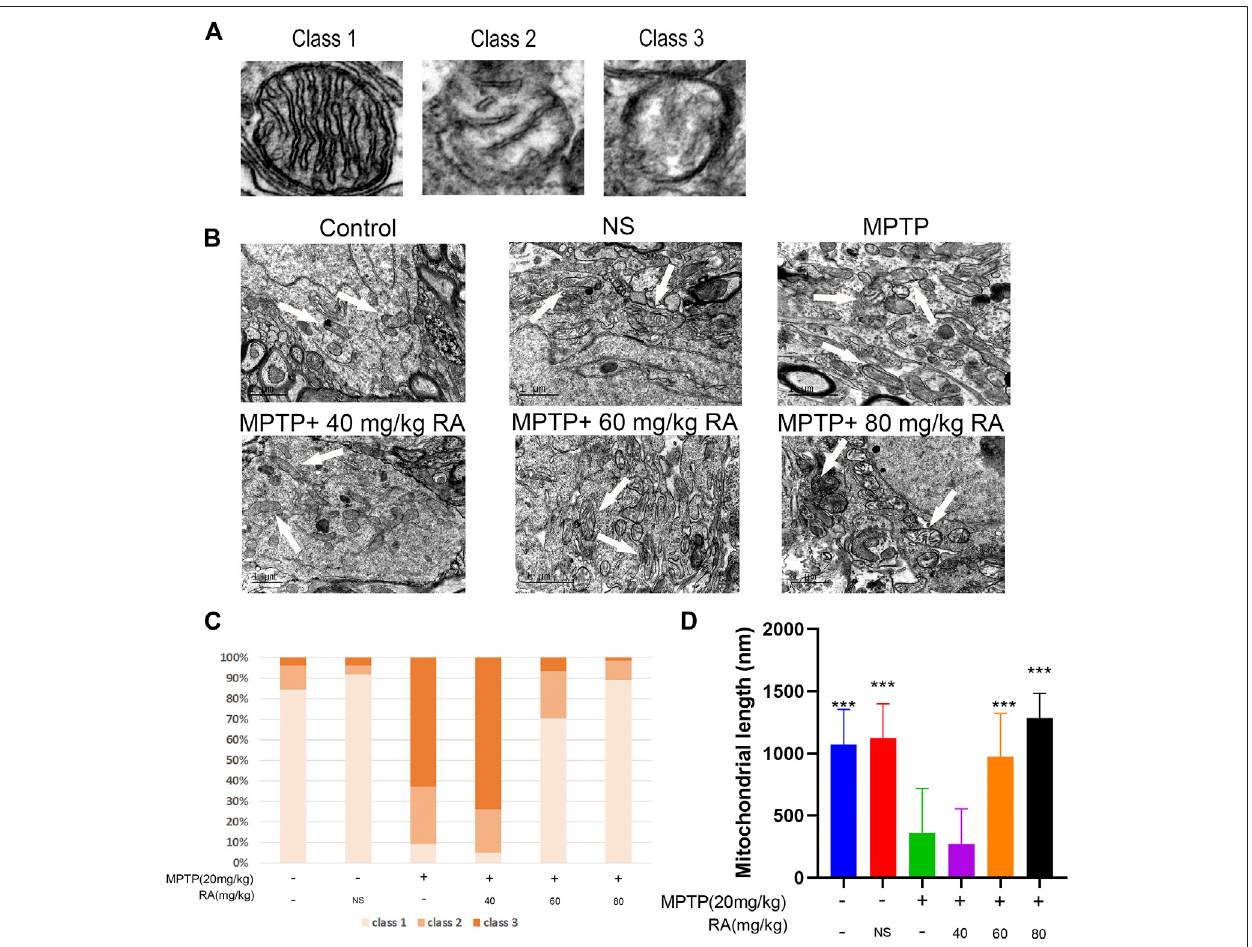
FIGURE 3 | The restored mitochondrial cristae morphology and mitochondrial length after cerebral MPTP injections in vivo by RA pre-administration. (A) Representative transmission electron microscopy (TEM) images of mitochondrial cristae number and matrix density. (B) Representative TEM images in the cortex of different experimental groups. (C) 40 – 70 mitochondria per experiment were scored in three categories: beyond four cristae (Class I), two or three cristae (Class II), no morethanonecrista(ClassIII)permitochondrion. (D) Representativequantitativeresultsofmitochondriallengthwith40 – 70mitochondriaperexperiment.Dataare expressed as mean ± SD. One-way analysis of ANOVA with Tukey ’ s test was used. N = 3 mice per group, * p < 0.05, ** p < 0.01, *** p < 0.001 when compared with the MPTP